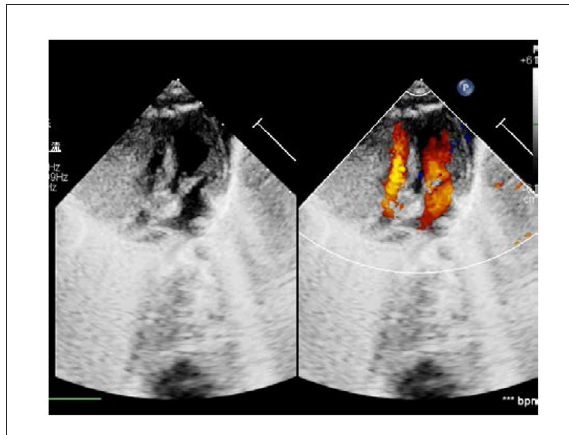
FIGURE1 Ultrasonic Cardiogram: Neoplastic mass on the right ventricular wall and constricted right cardiac cavity.